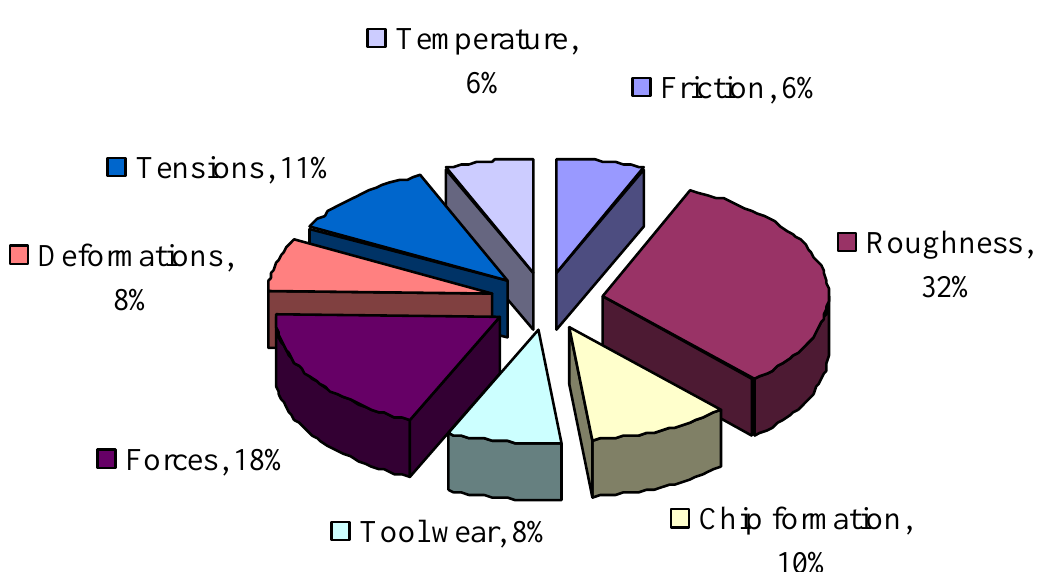
Figure 3. The studied research directions on aluminum alloy machining 2005–2019 period.